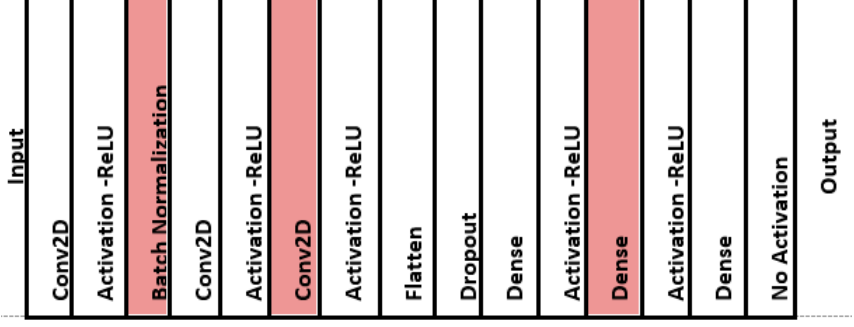
Figure 8. Layered architecture for hurricane intensity estimation.